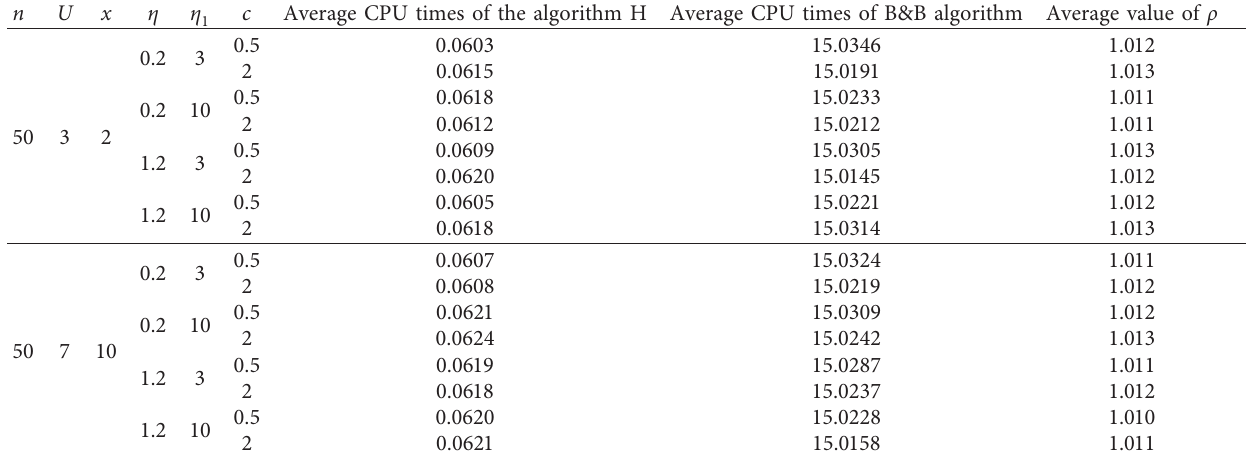
Table 4: The results of the algorithm H and branch-and-bound (B&B) algorithm for ( P 1). c n U x η η 1